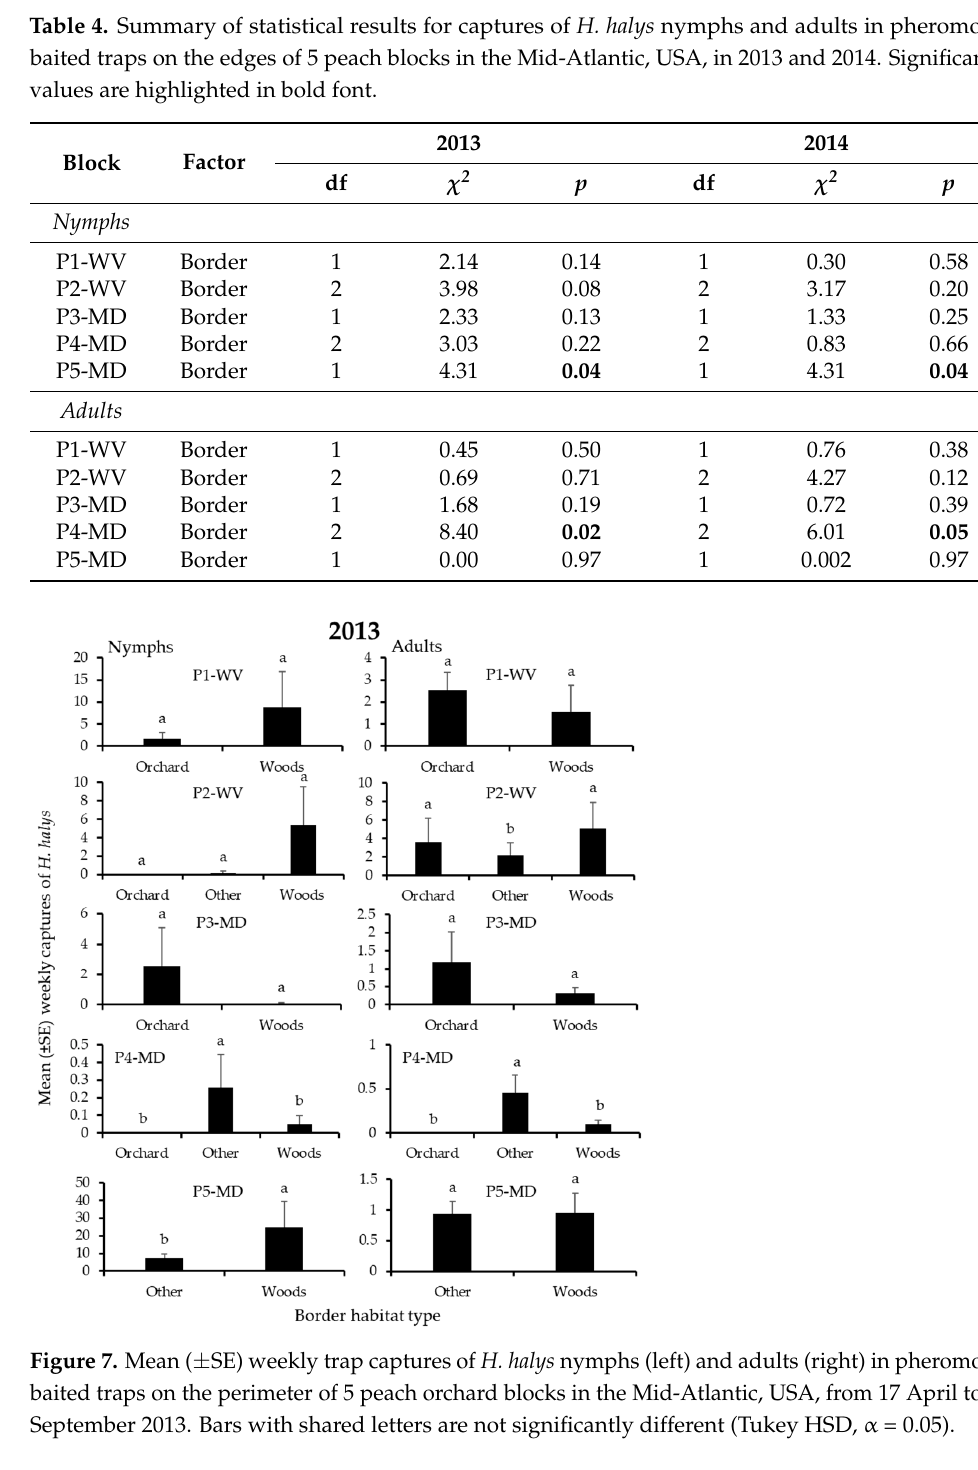
Figure 8. Mean (± SE) weekly trap captures of H. halys nymphs (left) and adults (right) in phero- mone-baited traps on the perimeter of 5 peach orchard blocks in the Mid-Atlantic, USA, from 7